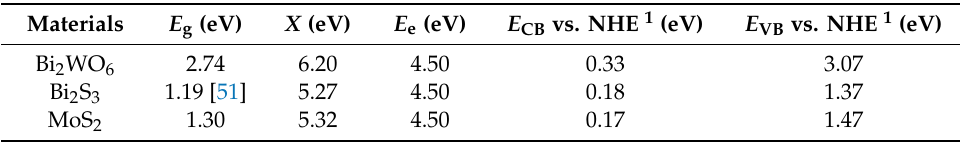
Table 1. Summary of the band gap energy ( E g ), conduction band edge ( E CB ), and valence band edge ( E VB ) of Bi 2 WO 6 , Bi 2 S 3 , and MoS 2